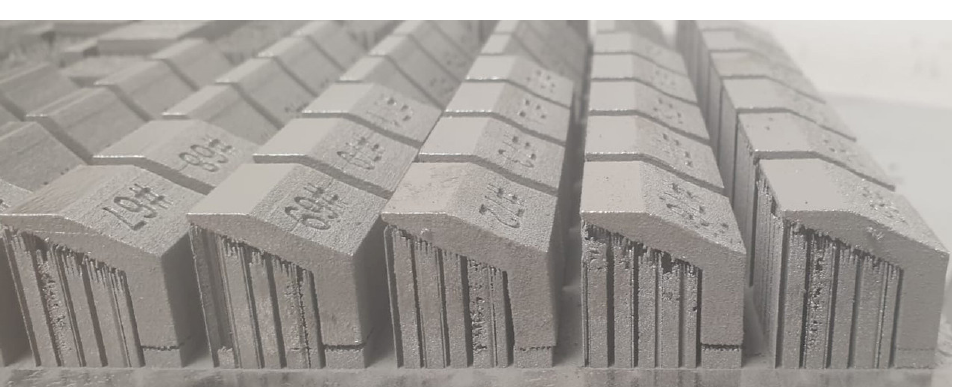
Figure 3. Printed